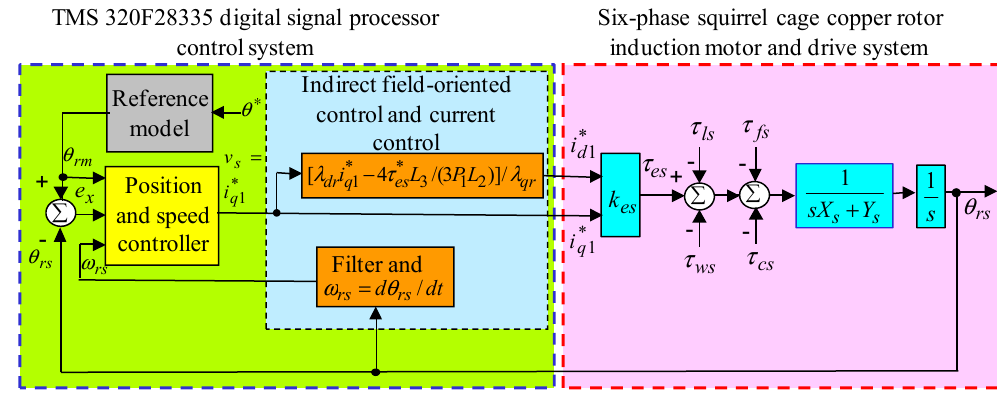
Figure 2. Predigested control block diagram.